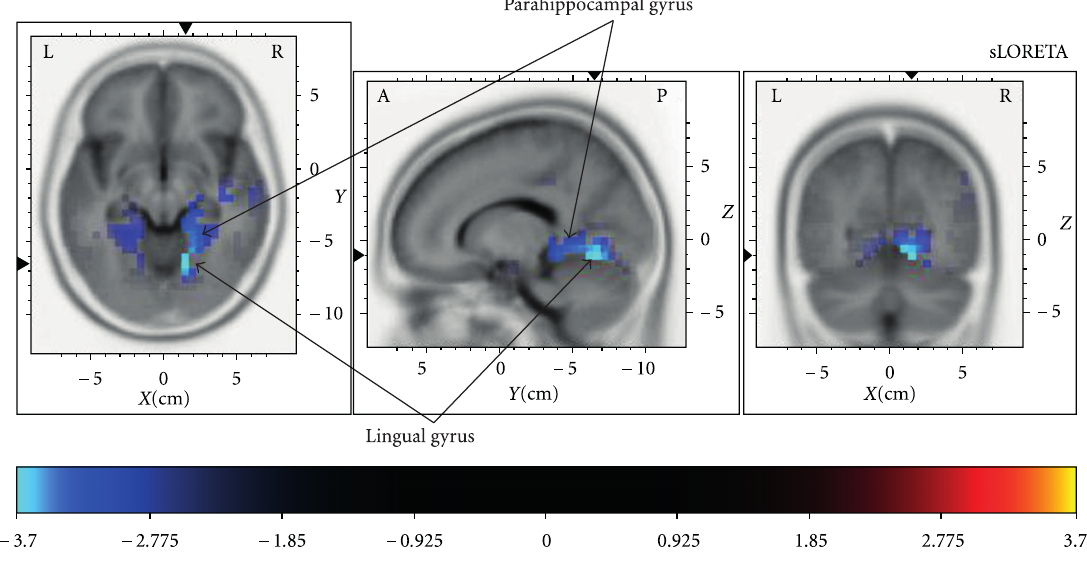
Figure 3: Graphical representation of the sLORETA results comparing the di ff erences of the target-P2 between test sessions exemplarily for the independent group test including the cognitive training group and the no-contact control group. Similar results were obtained when including the social control group. The blue colour indicates local maxima of lower activation in the first compared to the second test session for the cognitive training group in the right lingual and parahippocampal gyri, which may explain the amplitude di ff erence of the P2 between sessions in the tested interval surrounding the P2